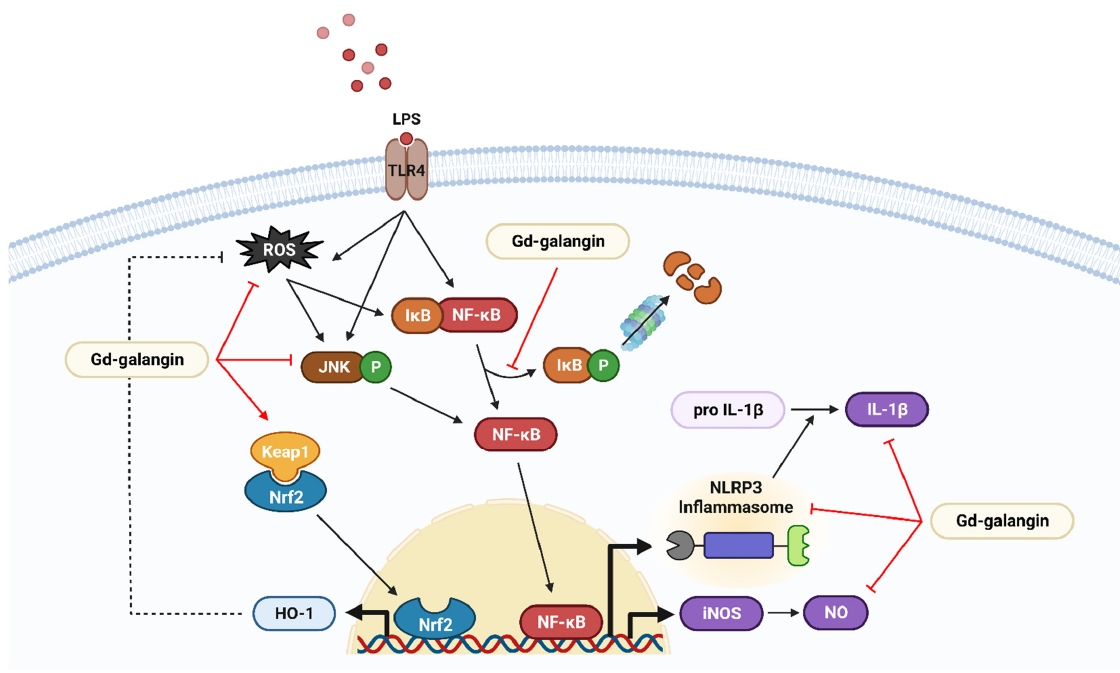
Figure 14. Anti-inflammatory signal pathway of Gd-galangin. The inflammatory response is an important response for survival dominated by in- flammatory cytokines and chemokines. In previous studies, galangin regulated the sub- factors NO and IL-1 β while inhibiting iNOS and NLRP3 inflammasome expression (Fig- ures 6 and 8). In particular, NLRP3 inflammasome activation is targeted for inflammatory treatment because it promotes inflammation and induces disease development [56,57]. IL- 1 β is an inflammatory cytokine that matures by activated NLRP3 inflammation [58]. Gd- galangin reduced IL-1 β expression due to its contribution to NLRP3 and ASC inhibition (Figure 9). Under normal conditions, I κ B α binds to NF- κ B, thereby suppressing its trans- location to the nucleus. Contrastingly, under conditions of LPS-induced stress, phosphor- ylation of I κ B α triggers the release of NF- κ B, thereby restoring nuclear translocation [59]. In light of the previously reported performance of galangin, Gd-galangin also shows that inhibition of phosphorylation of I κ B α inhibits NF- κ B potential to the nucleus (Figure 11). In response to oxidative stress, Nrf2 mediates the upregulation of HO-1, thereby initiating antioxidant activity. This upregulated expression of HO-1 contributes to the maintenance of redox homeostasis via multiple mechanisms [37]. In these processes, Keap1 generally binds to Nrf2, thereby suppressing its translocation to the nucleus. Given that it has been established that phosphorylation of Nrf2 promotes its dissociation from Keap1, this thereby contributes to the expression of HO-1 [60]. According to previously reported pa- pers, Gd-galangin exerts antioxidant effects by promoting the phosphorylation of Nrf2 and upregulating HO-1 expression (Figure 12). The MAPK signaling pathway is a cascade of serine/threonine kinases that regulate cell survival and death [61]. Erk, JNK, and p38 are the members of MAPK family which contribute to LPS-stimulated inflammation by phosphorylation [62,63]. Galangin showed a tendency to inhibit Erk, JNK, and p38, but Gd-galangin showed particularly prominent anti-inflammatory activity against JNK (Fig- ure 10). There is a limitation to directly compare the anti-inflammatory effects of galangin and Gd-galangin. However, in this study, Gd-galangin sufficiently proved its antioxidant and anti-inflammatory effects. Considering that inflammation is an important hospital